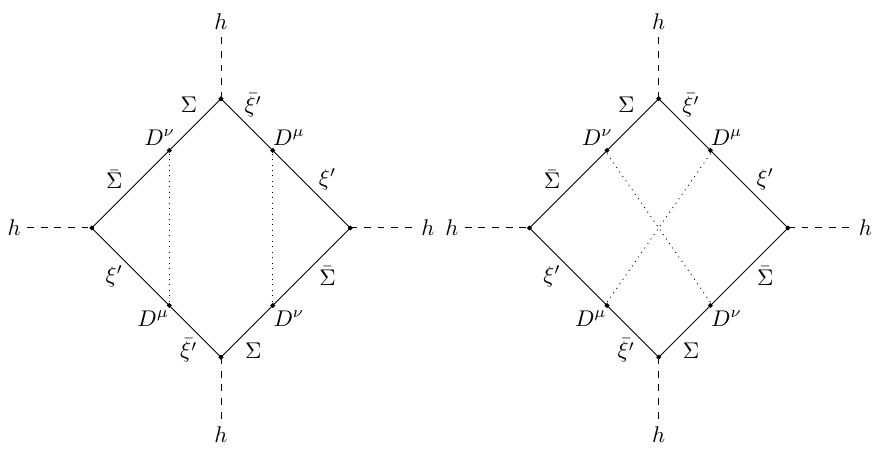
Figure 5 . Diagramatic contribution to the Skyrme term before integrating out the heavy degrees of freedom Σ and ξ 0 defined in eqs. (4.9) and (4.10). D refers to the covariant derivative.